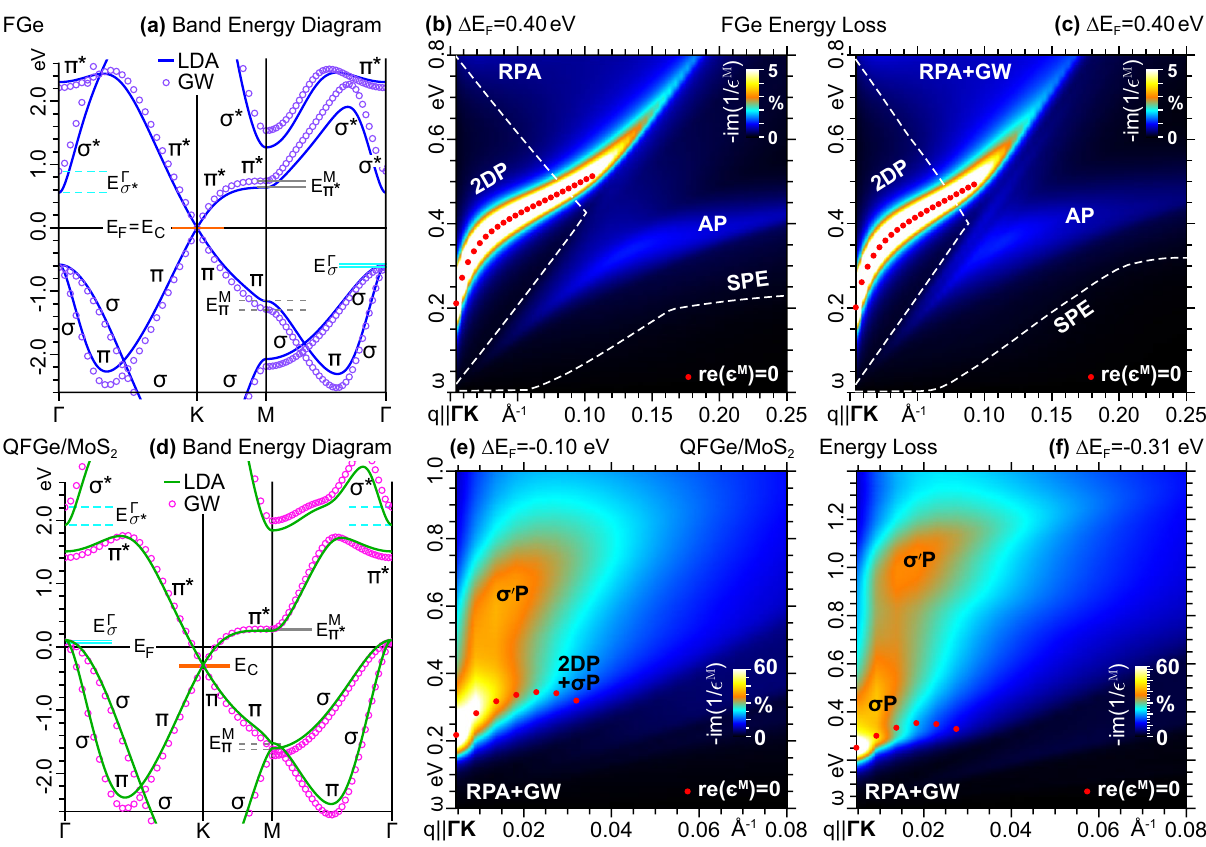
0.4 eV , obtained ( b ) Figure 9. ( a ) LDA vs GW bands and ( b ), ( c ) loss function (in arb. units) of FGe for (cid:31) E F = with the LDA electronic structure (within the TDDFT-RPA approach) and ( c ) with the GW correction to the LDA energies (within the TDDFT-RPA+GW approach). The dashed white lines delimit the full SPE region. ( d ) LDA vs GW bands and ( e ), ( f ) loss function (in arb. units) of QFGe on MoS 2 , obtained with the GW corrected 0.31 eV (within the TDDFT-RPA+GW approach). The density maps in 0.10 eV and ( f ) energies for ( e ) (cid:31) E F − =− Figs. 6a and 7a are the TDFT-RPA counterparts of ( e ) and ( f ). The color scale is normalized to the highest FIR- MIR peak, with the undamped plasmon resonances, dominant plasmon modes, and other energy labels marked as in Figs.